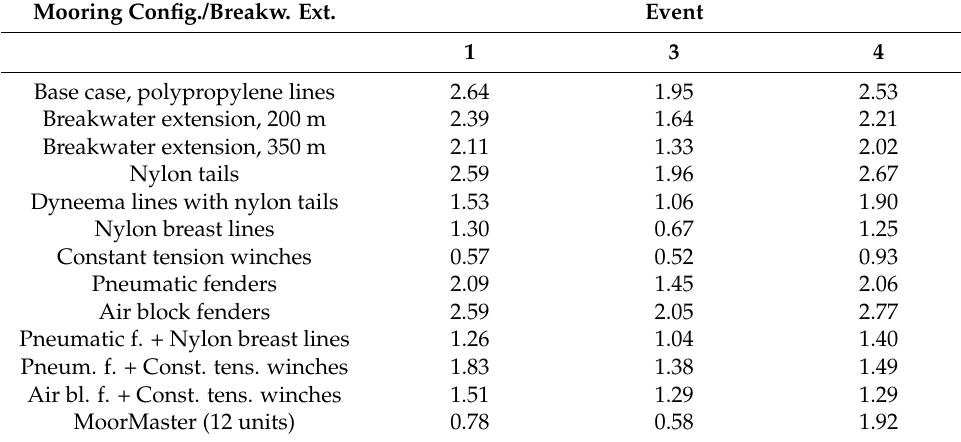
Table 9. Maximum yaw motions (deg).